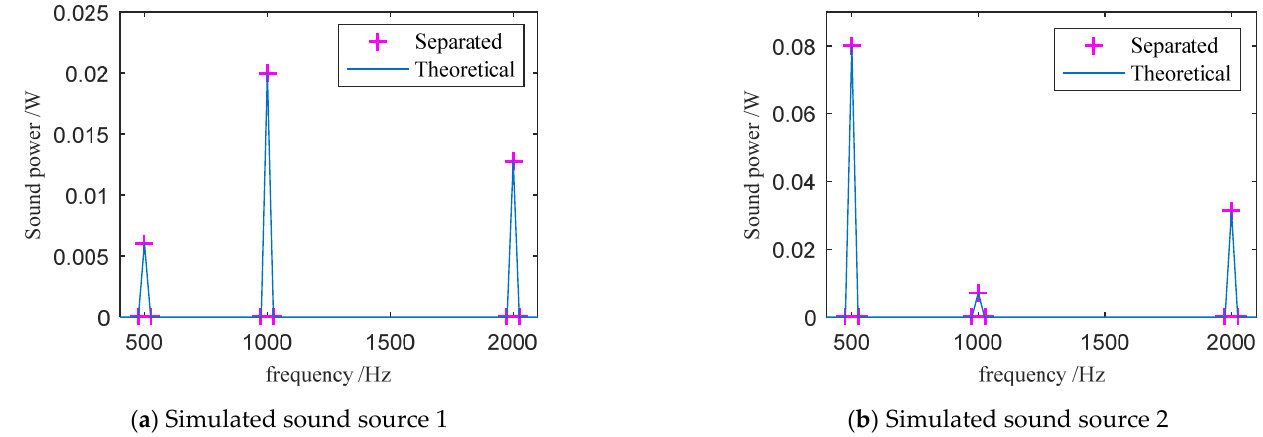
Figure 2. Comparison of the separated sound power spectra and the theoretical values.